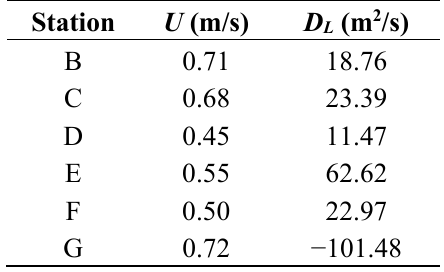
Table 3. Experimental values of flow velocities and longitudinal dispersion